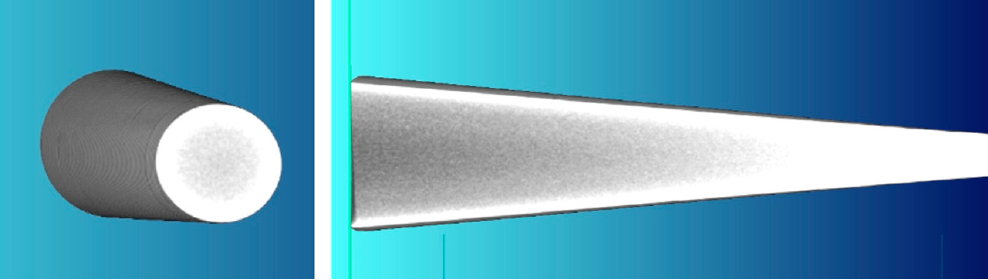
Figure 7. Results of the CT scan of the working (conical) part of the harrow tooth preform.